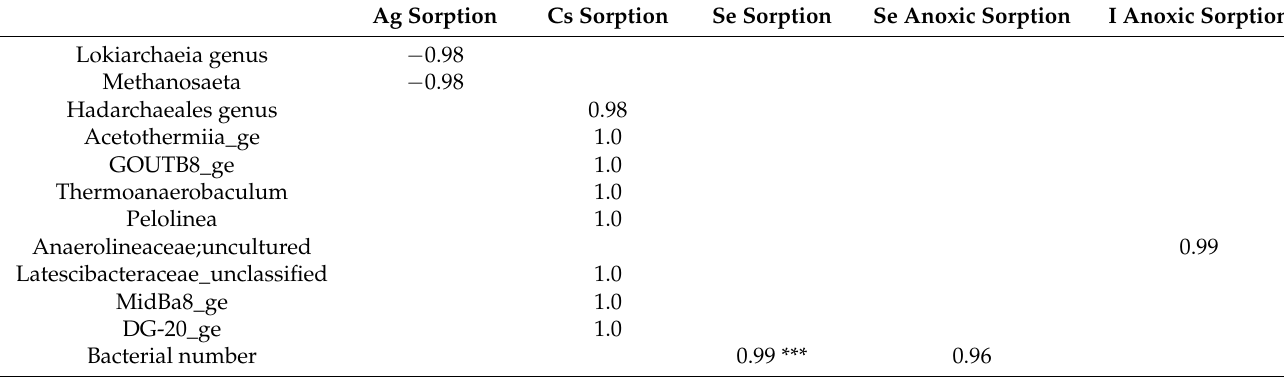
Table 7. Pearson correlation coefficients of the Bonferroni corrected correlations between relative abundance of bacterial genera or bacterial numbers and sorption data. Correlation coefficients for pairs with p < 0.05 are shown. Ag Sorption Cs Sorption Se Sorption Se Anoxic Sorption I Anoxic